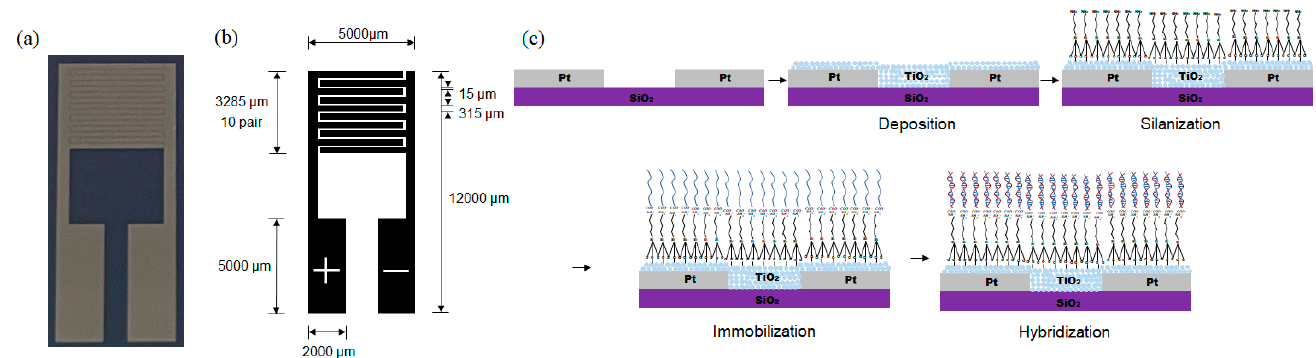
Figure 1. ( a ) Photograph of a Pt IDE. Schematic diagrams of ( b ) the Pt IDE with dimensions and ( c ) the fabrication process of the DNA biosensor on a Pt IDE.